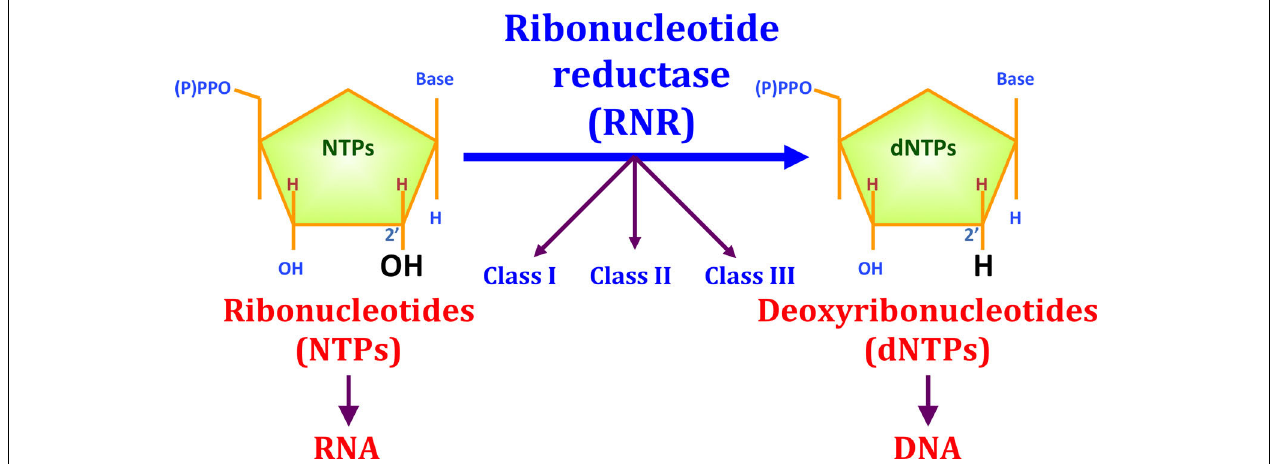
FIGURE 1 | The reduction of ribonucleotides to deoxyribonucleotides by RNR. Three different RNR classes (I, II, and III) have been described for this enzyme family. RNR is important for evolution, as